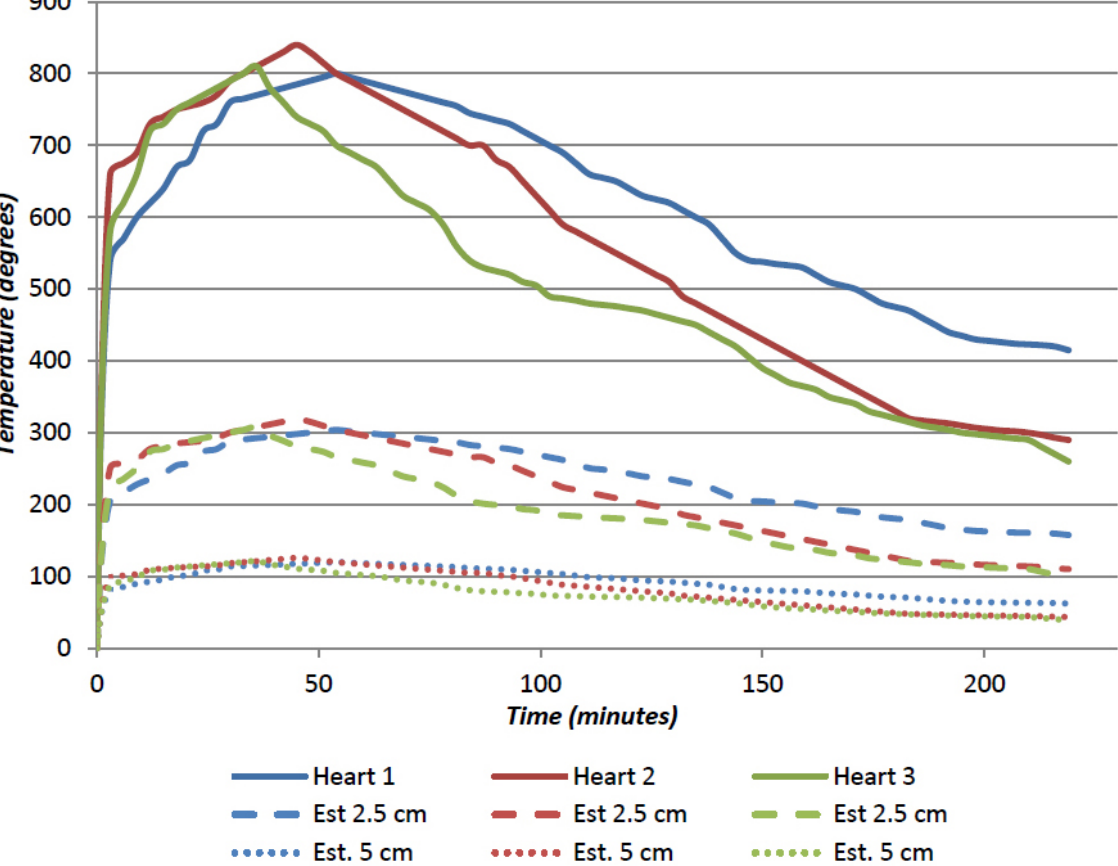
Figure 7. Evolution of surface temperature for each of the experimental set-ups and estimation of layer temperature. Hearth 1 (69 blanks of Bergerac flint) and hearth 2 (70 blanks of SMM flint) where employed to test differential heat impact among lithic artifacts. Hearth 3 was designed to test direct throwing of flint blanks and recycling after